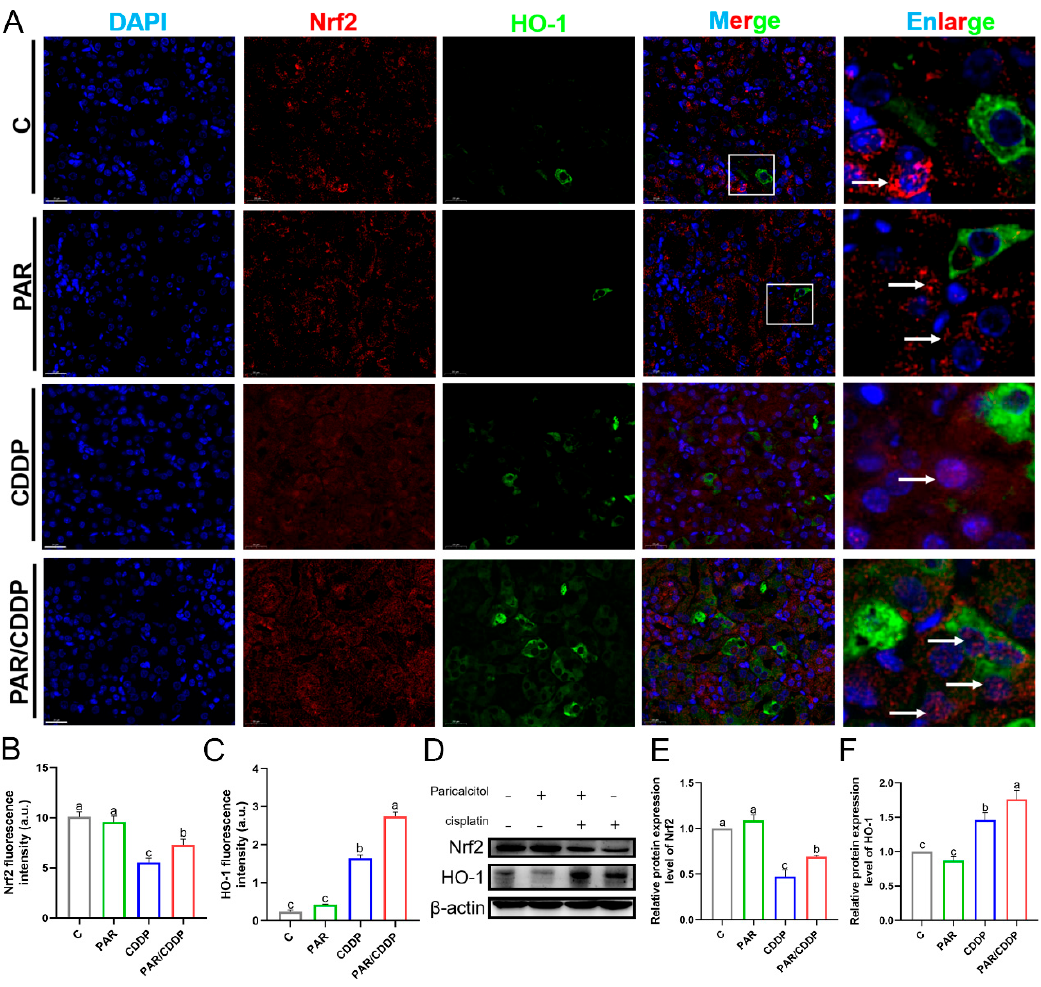
Figure 5. Paricalcitol activated the Nrf2/HO-1 signaling pathway in mice kidneys. ( A – C ) Representative images and quantification for immunofluorescence of Nrf2 (red) and HO-1 (green) (scale bars, 20 µ m; n = 3). ( D – F ) The protein expressions of Nrf2 and HO-1 in mice kidneys ( n = 3). C, control group; PAR, paricalcitol group; CDDP, cisplatin group; PAR/CDDP, paricalcitol + cisplatin group. Bars that do not share the same letters are significantly different ( p < 0.05) from each other. Results are presented as Mean ± SD. Statistical significance was obtained by one-way ANOVA.